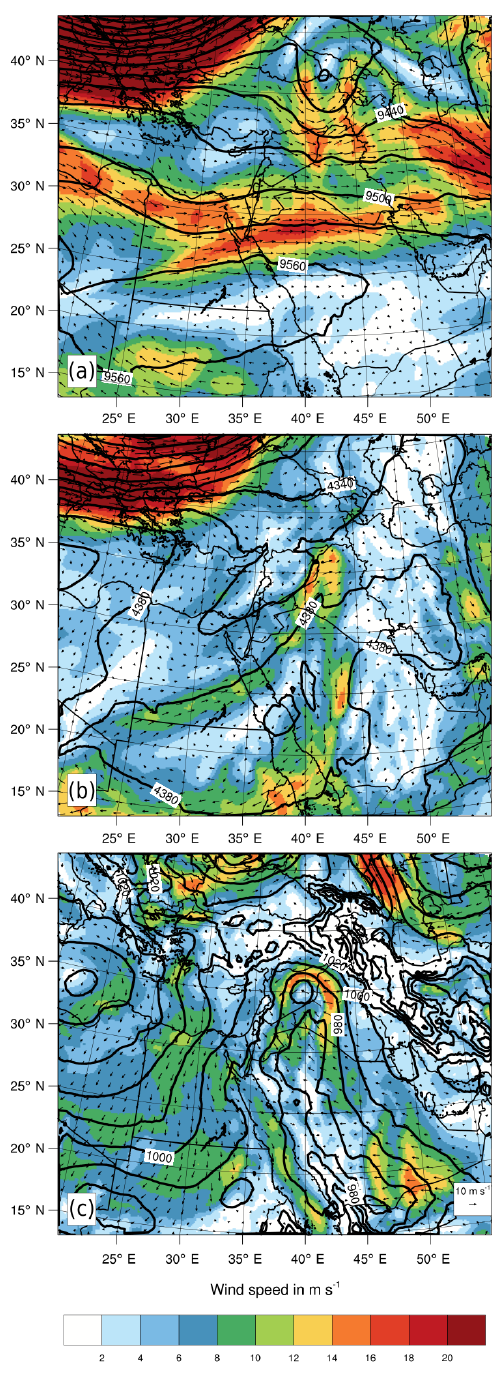
Figure 3. Synoptic situation on 6 September at 18:00UTC as simulated by ICON-ART for the global domain. Shown are the (a) 300hPa, (b) 600hPa and (c) 900hPa levels. Black lines denote the height of the respective pressure level in geopotential metres. Wind speed is colour-coded, and wind velocity is shown as